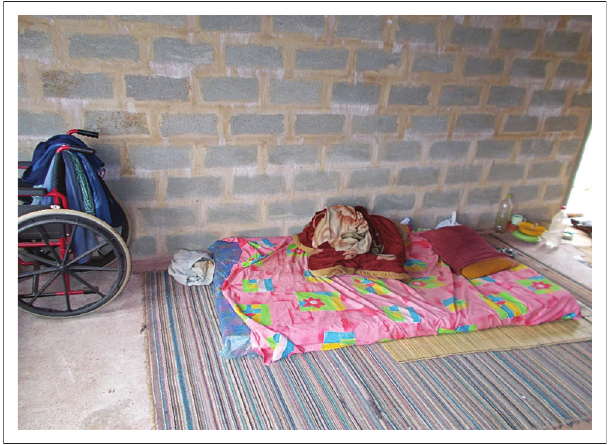
Source : D. Naidoo FIGURE 3: Moving oneself with a disability from a matress on the floor into a wheelchair is difficult for most PWDs and requres additional skills and strength, which is different from transferring them from a standard raised